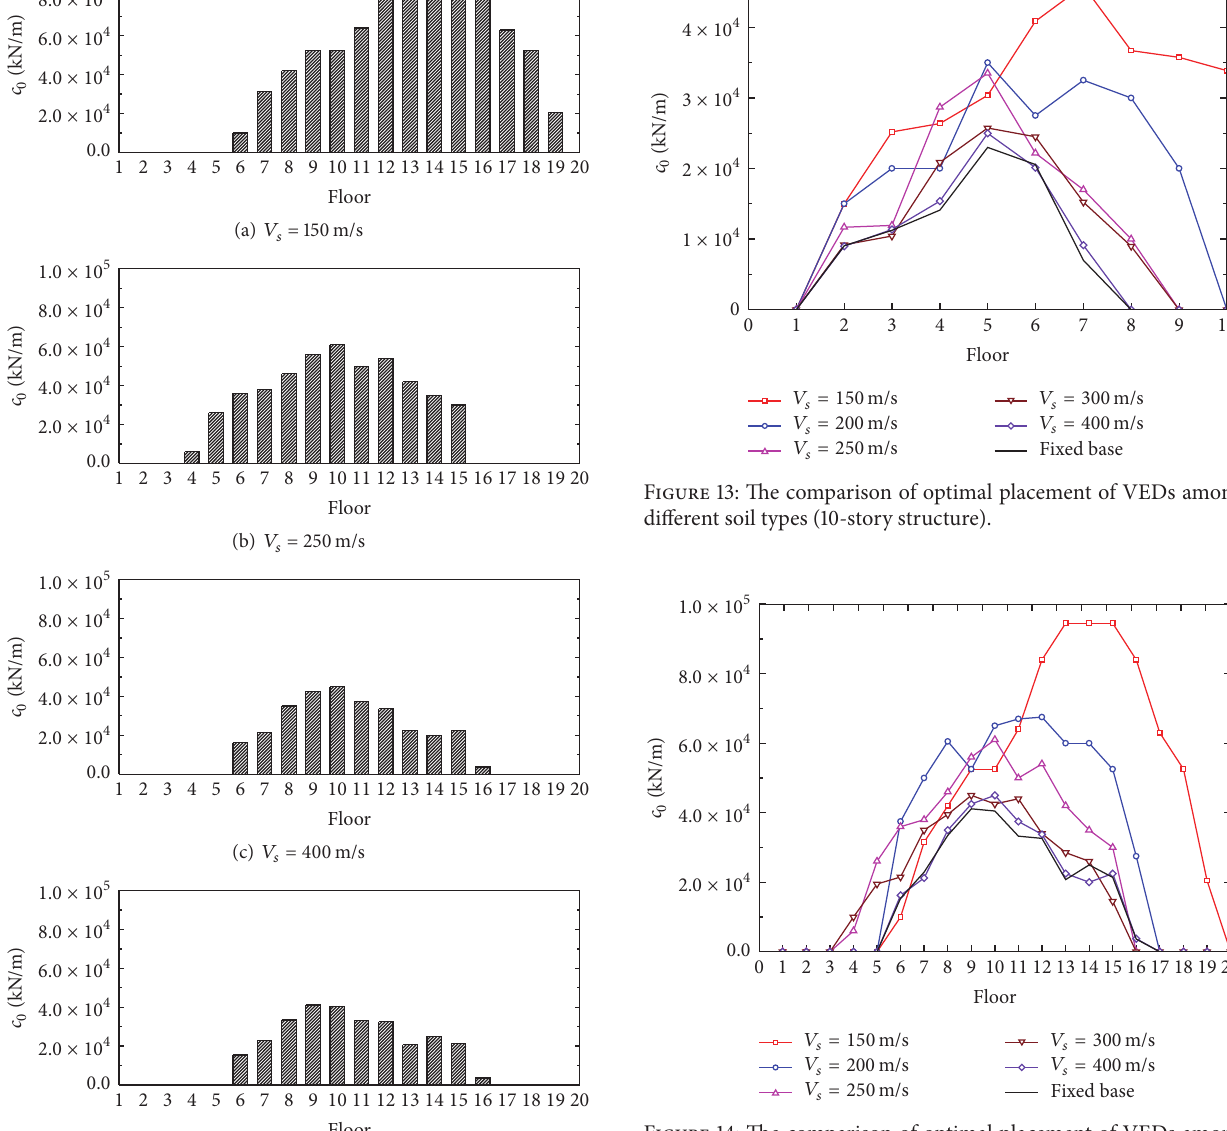
Figure 14: The comparison of optimal placement of VEDs among different soil types (20-story